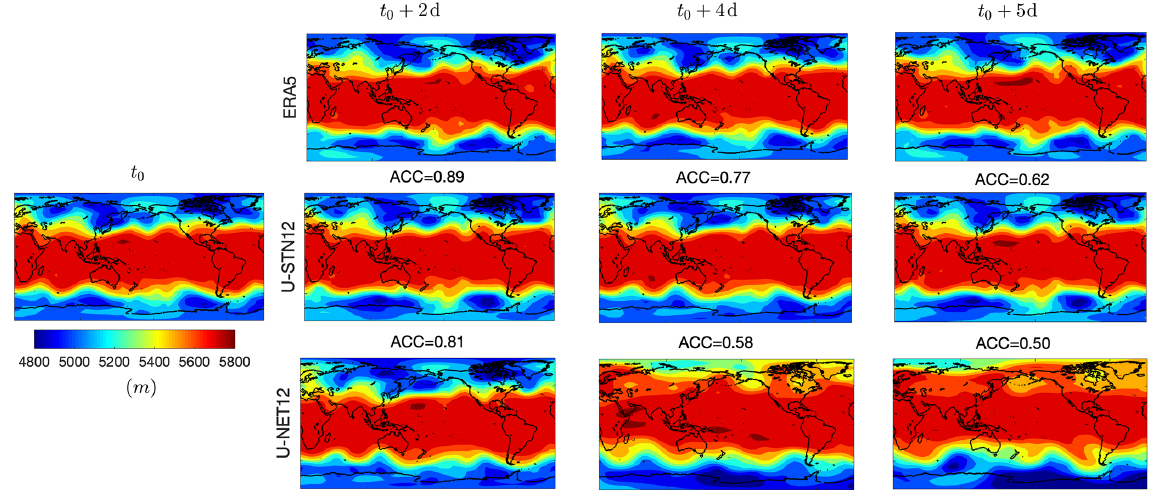
Figure 4. Examples of the spatiotemporal evolution of Z500 predicted from a noise-free initial condition ( t 0 ) using U-STN12 and U-NET12 and compared with the truth from ERA5. For the predicted patterns, the anomaly correlation coefficient (ACC) is shown above each panel (see the text for